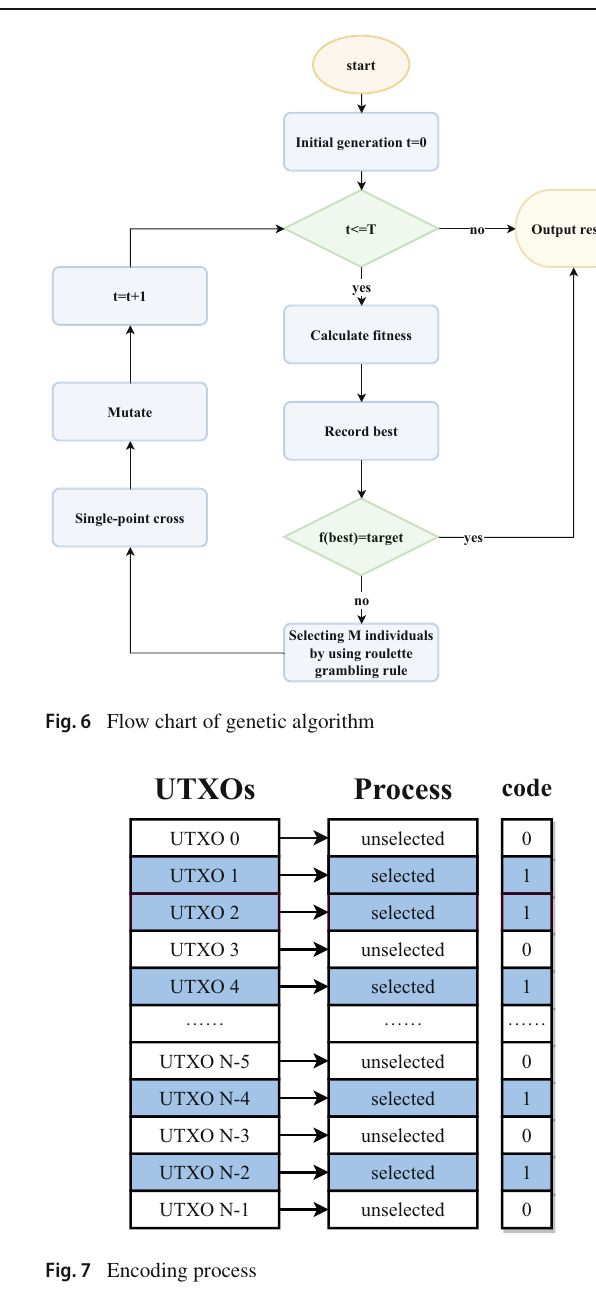
Fig. 5 Flow chart of whole process